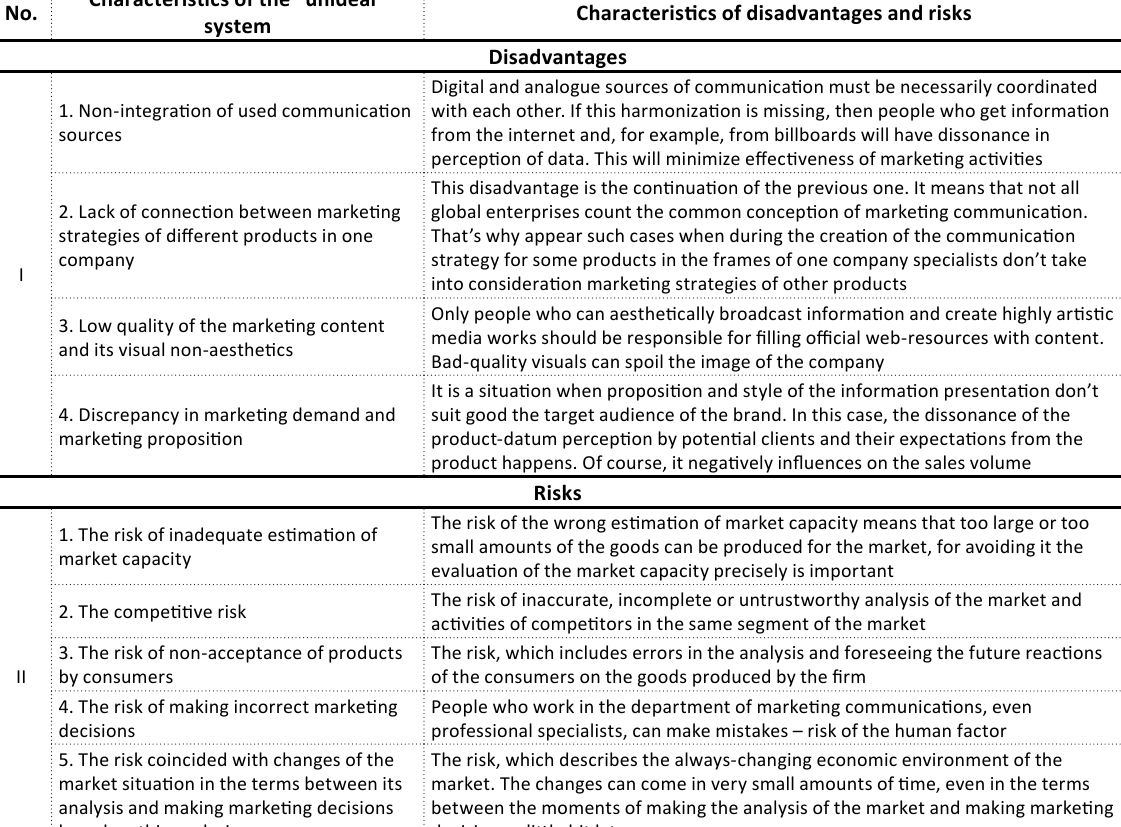
Table 1. Disadvantages and risks of the “unideal” system of global marketing communications from the management point of